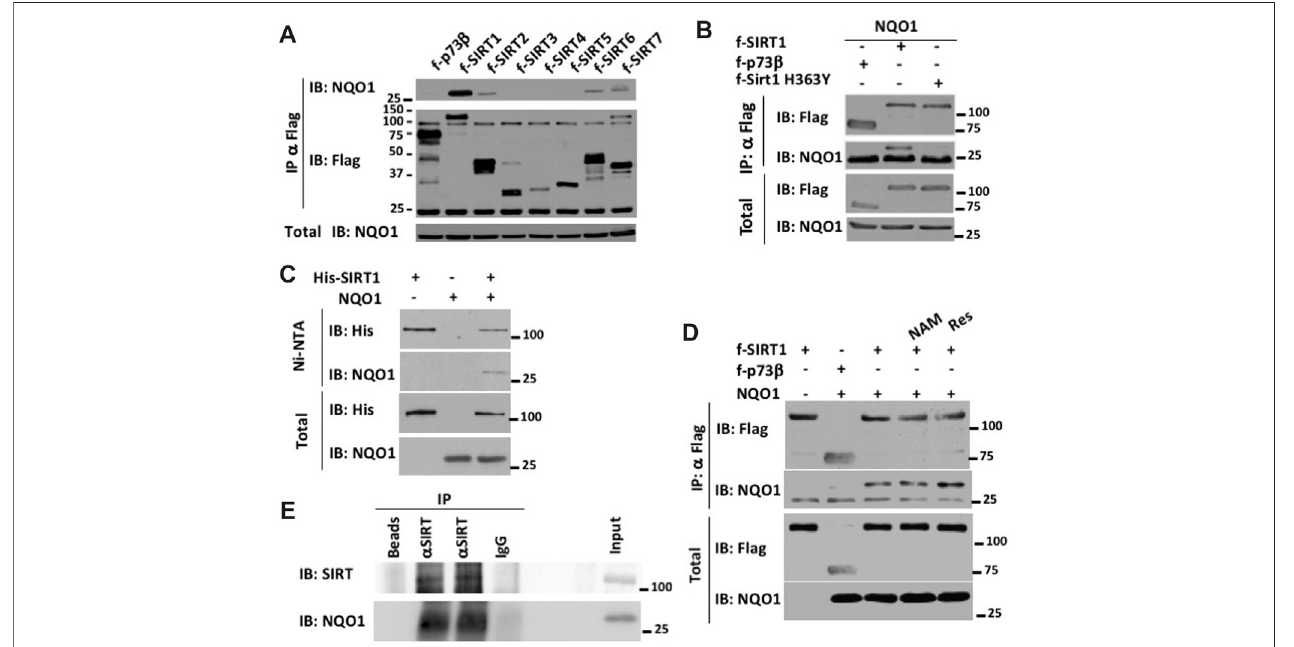
FIGURE 1 | SIRT1 directly binds NQO1. (A) HEK293 cells were co-transfected with NQO1 and fl ag tagged sirtuins (SIRT1-7) or p73 β (as negative control in all the transfection experiments). Following immunoprecipitation with fl ag beads the association of NQO1 was analyzed by immunoblot with the indicated antibodies. (B) Flag tagged SIRT1 or the SIRT1 H363Y mutant were co transfected in the presence of NQO1. The association of NQO1 was analyzed following immunoprecipitation with fl ag beads. (C) Bacteriallyexpressed and puri fi edHis-SIRT1and NQO1wereincubated and the bindingofNQO1was analyzed following precipitationofHis-Sirt1withNi- NTA beads. (D) HEK293 over expressing fl ag tagged SIRT1 and NQO1 were treated with 10 mM NAM or 50 μ M Resveratrol for 16 h and the association of NQO1 was examined following immunoprecipitation with fl ag beads. (E) Endogenous SIRT1 and NQO1 interact. Mouse liver extracts were immunoprecipitated (IP) with control empty beads, control IgG-coated beads, or anti-SIRT1-coated beads; and protein levels were analyzed by Western blotting (IB). The results of two anti-SIRT1 IPs are